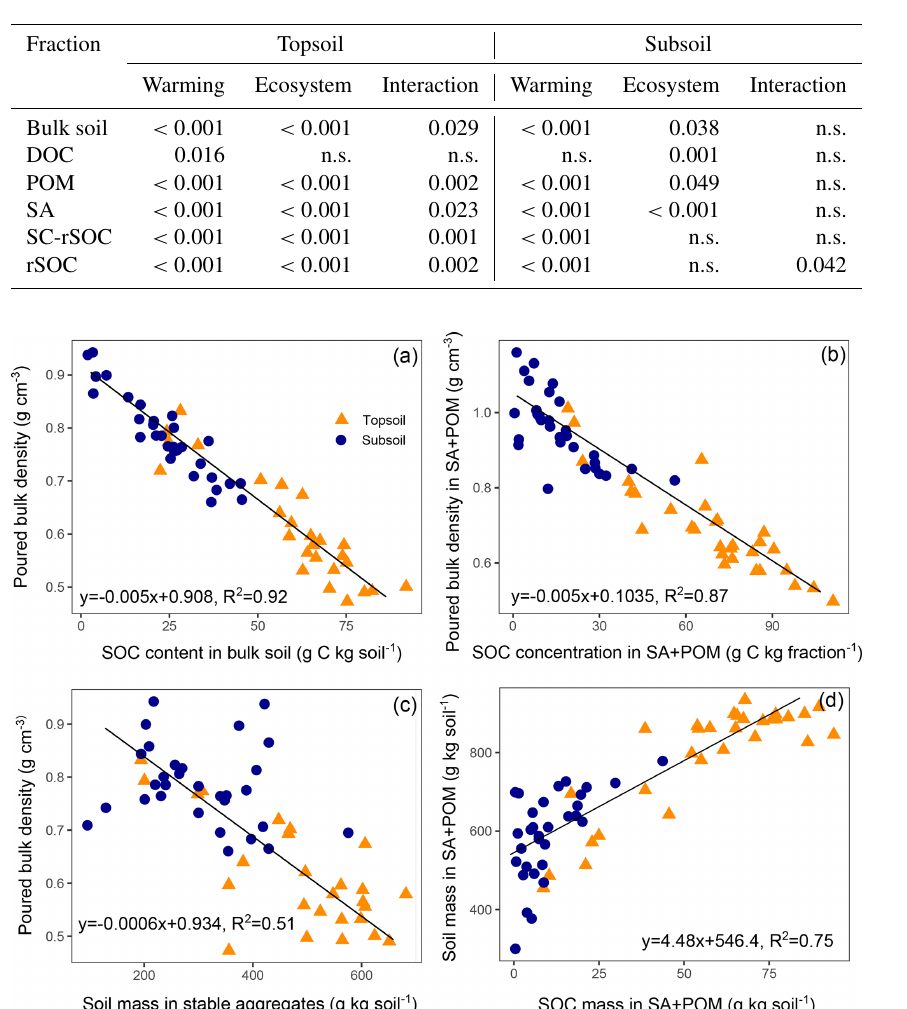
Table 3. Summary of the linear regression models ( p values) assessing the effects of warming, ecosystem (grassland vs. forest) and their interaction on soil organic carbon (SOC) for the bulk soil and all isolated fractions.